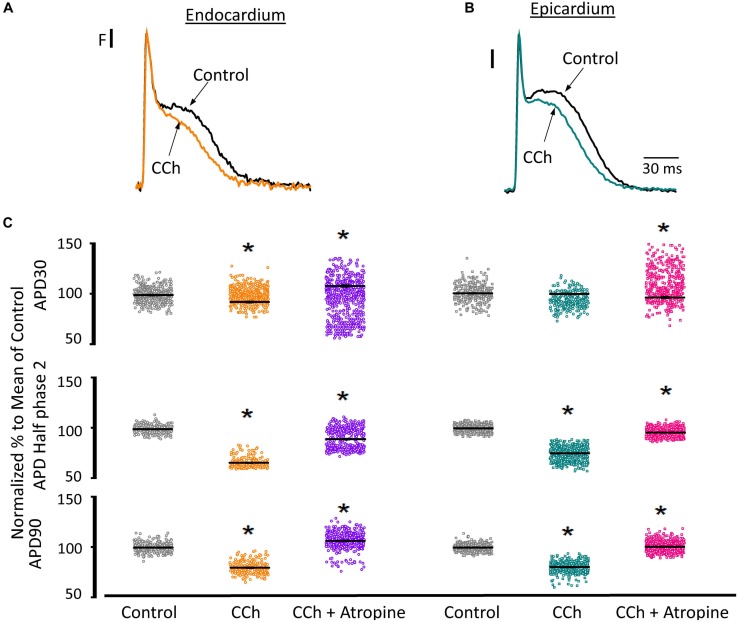
Cholinergic stimulation modifies overall AP morphology in endocardium and epicardium. (A) Normalized APs recorded optically with Di-8-ANEPPS from the endocardium and (B) epicardium before and after perfusion with 5 μM carbachol (CCh). (C) Summary of the normalized APD30, APD half phase 2 and APD90 changes from the endocardium (circles) and epicardium (squares), before and after carbachol, and after carbachol plus atropine. Means ± SEM are represented as the solid horizontal lines. *p < 0.01, N = 5 hearts.